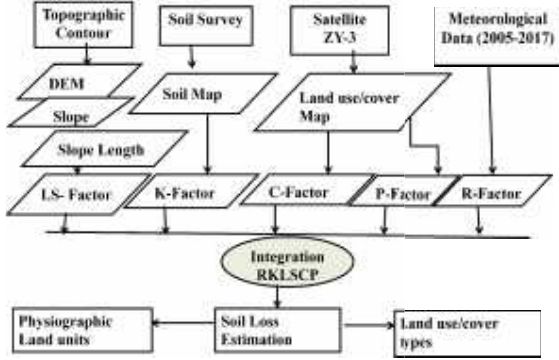
Figure 2. Conceptual framework for soil loss estimation